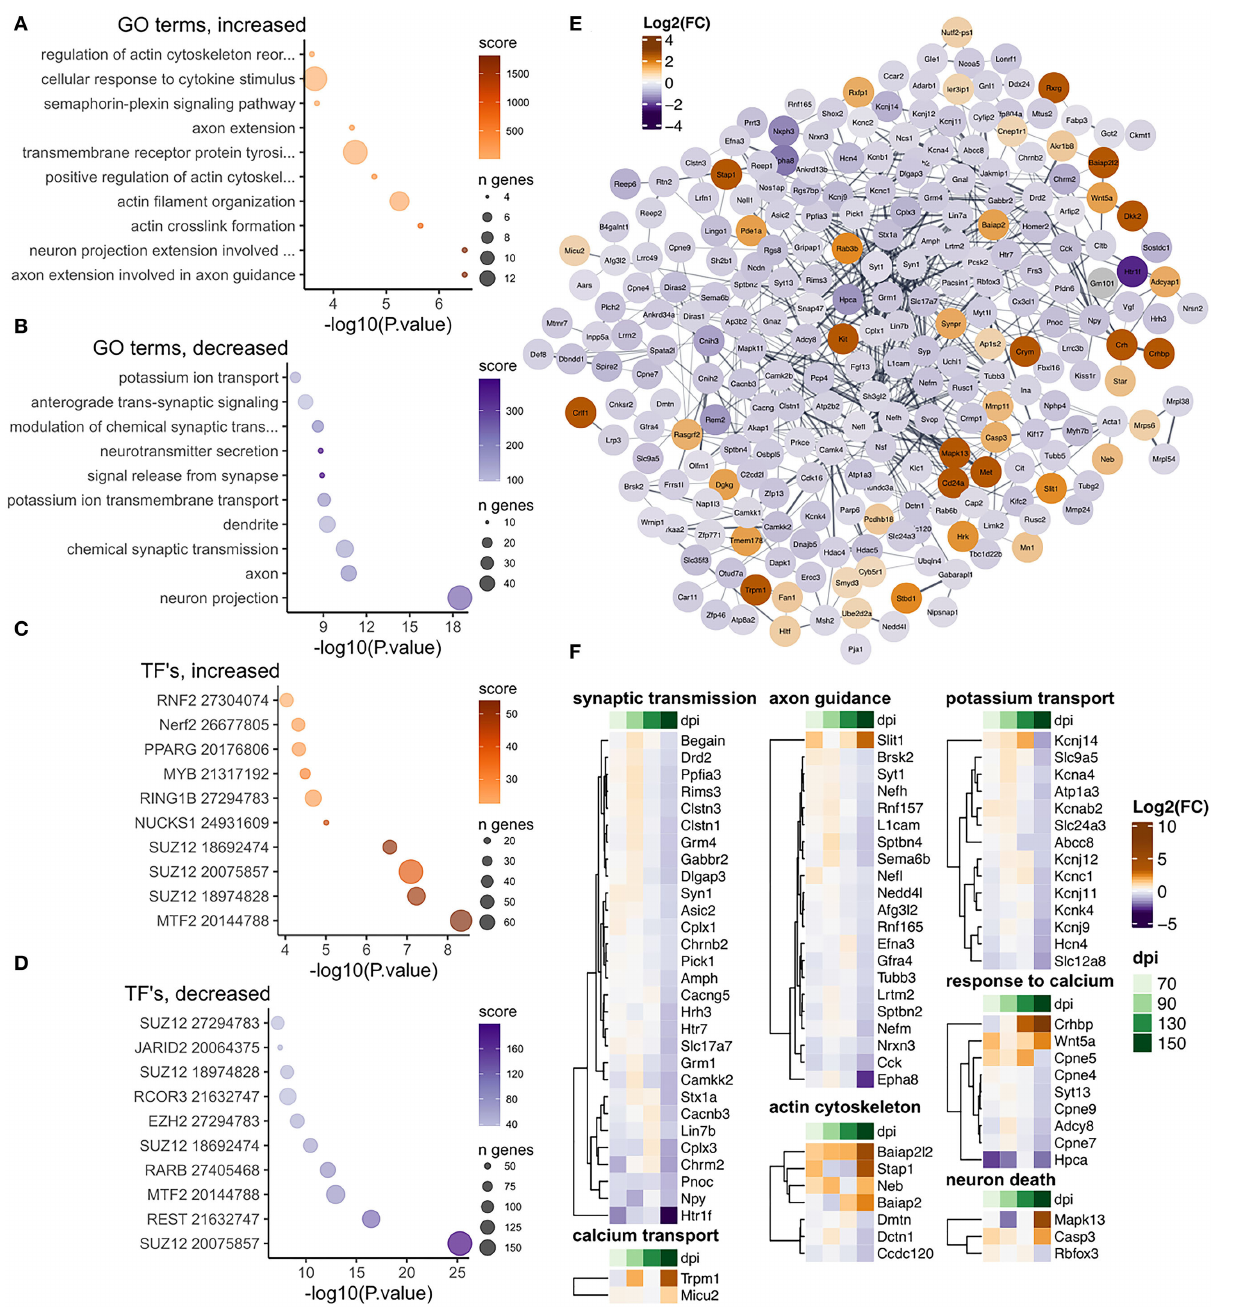
these thalamus neuron affiliated transcripts using the Allen brain atlas mouse ISH database. To further illustrate the